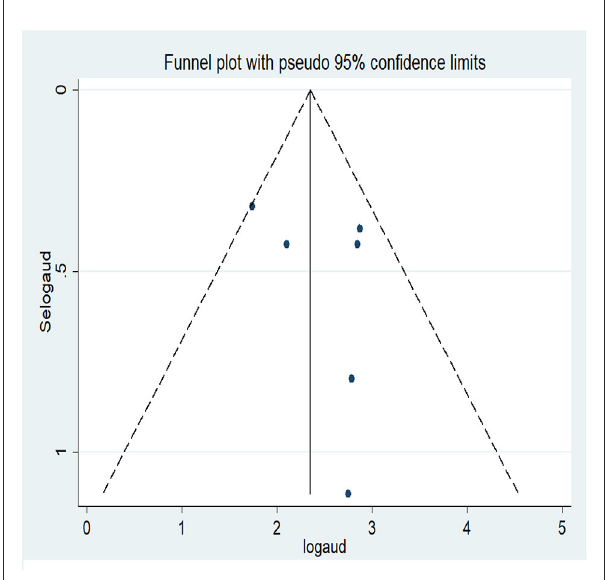
FIGURE4 Funnel plot of publication bias for lifetime prevalence of AUD.